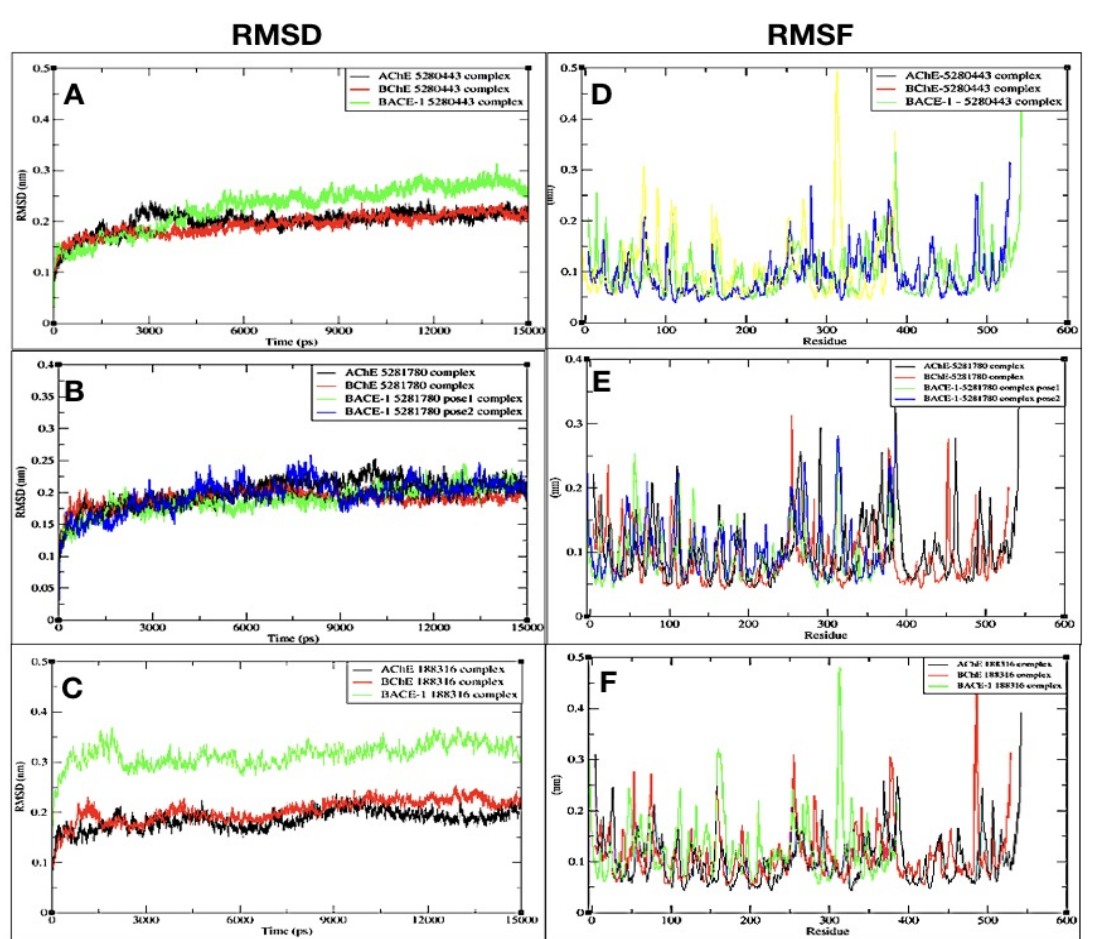
Figure 4. Root mean square deviations (RMSDs) of C-alpha atoms of complexes of ( A ) AChE- 5280443 , BChE- 5280443 , and BACE-1- 5280443 , ( B ) AChE- 5281780 , BChE- 5281780 , BACE-1- 5281780 -pose1, and BACE-1- 5281780 -pose2, ( C ) AChE- 188316 , BChE- 188316 , and BACE-1- 188316 , and the root mean square fluctuations (RMSFs) of residues of C-alpha atoms of complexes of ( D ) AChE- 5280443 , BChE- 5280443 , and BACE-1- 5280443 , ( E ) AChE- 5281780 , BChE- 5281780 , BACE-1- 5281780 -pose1, and BACE-1- 5281780 -pose2, and ( F ) AChE- 188316 , BChE- 188316 , and BACE-1- 188316 . Table 3. Average RMSD values and time (ns) at which all the complexes retained stability. Sr.No.